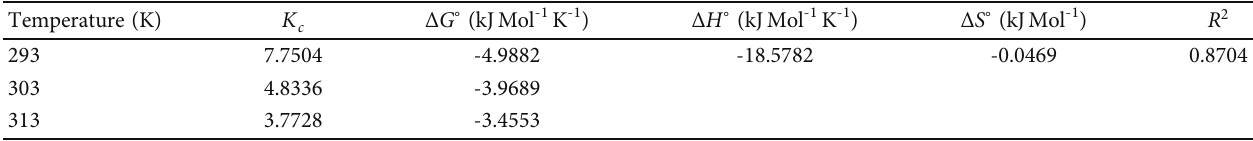
) of Neolamarckia cadamba with other adsorbents. max max